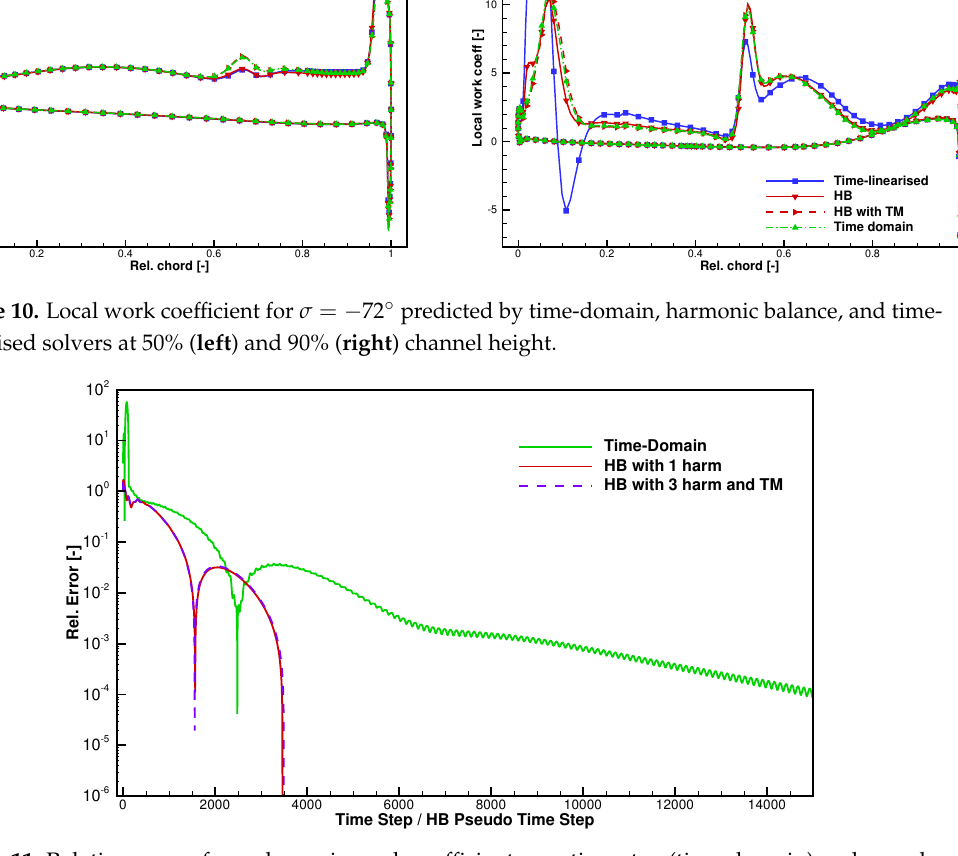
Figure 11. Relative error of aerodynamic work coefficient over time step (time-domain) and pseudo time step (HB) for σ = − 72 ◦